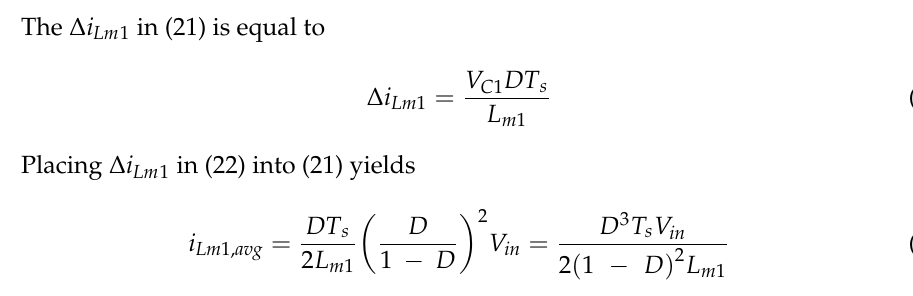
Figure 12. The waveform of magnetizing–inductance current i Lm 1 .